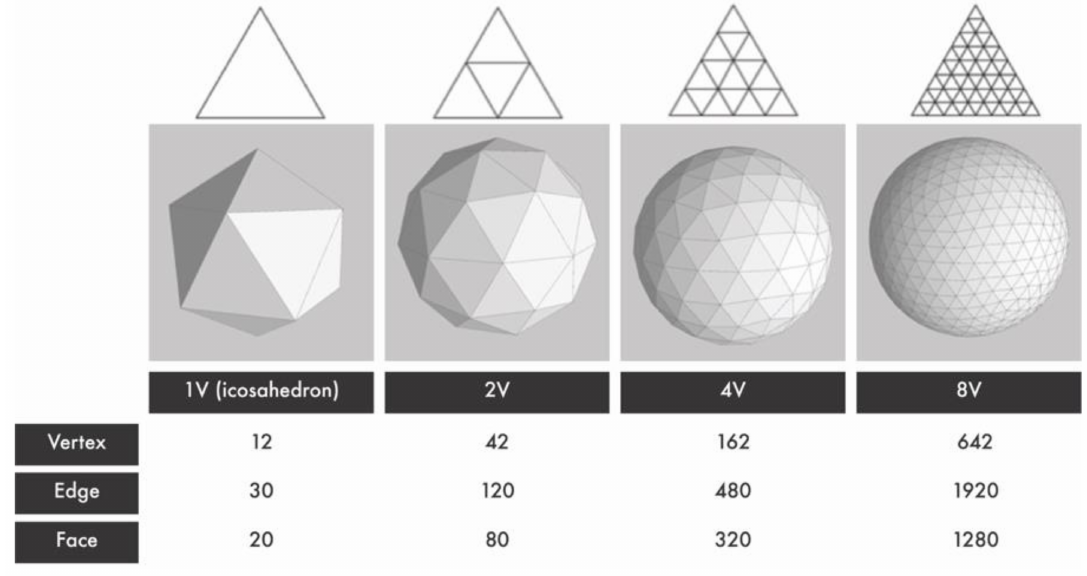
Figure 1. Number of vertices, edges, and faces according to the resolution of the icosphere.